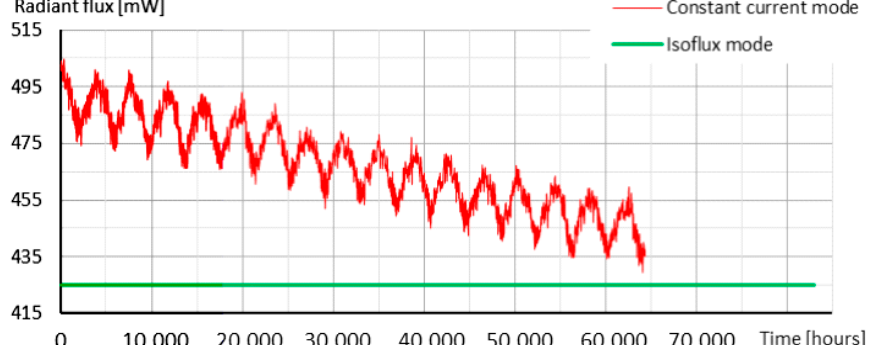
Figure 10. Simulated light output of a Luxeon Z LED.